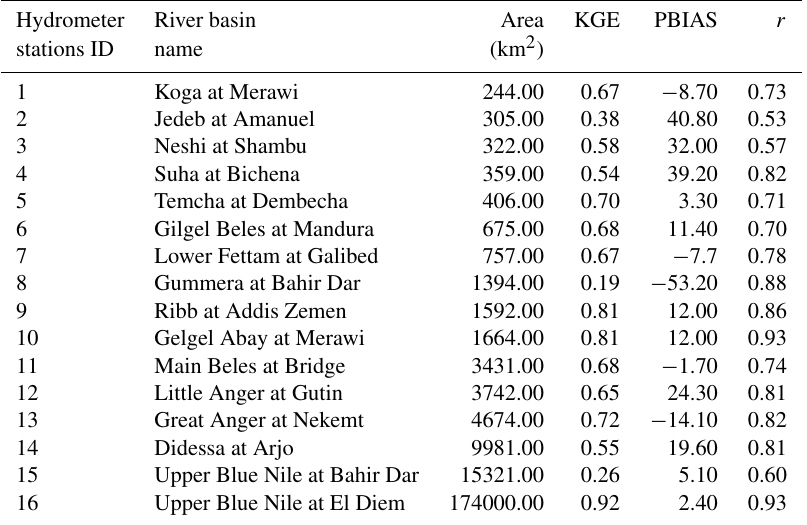
Table 4. The simulation capacity of the NewAge Adige rainfall–runoff component at the internal sites, based on the optimized parameters calibrated at the outlet. The performance at the outlet (El Diem) is the model performance during validation